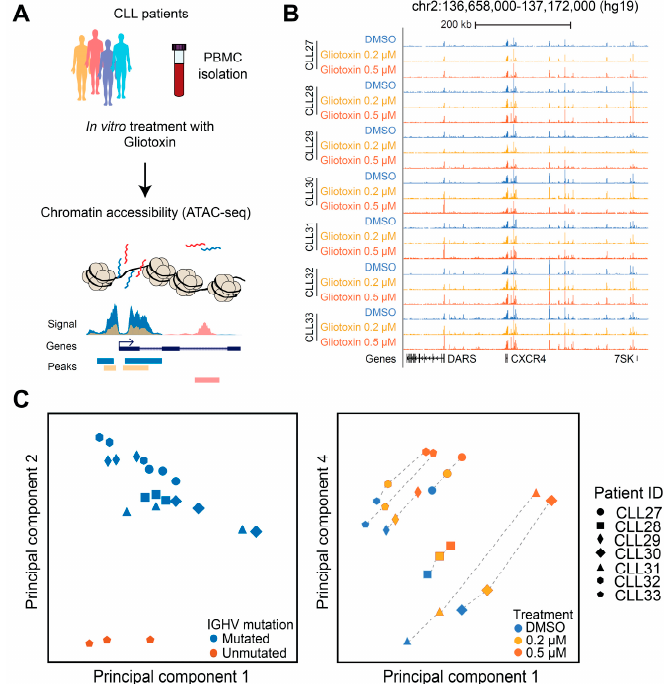
Figure 6. Chromatin accessibility changes in primary CLL cells upon in vitro treatment with gliotoxin. ( A ) ATAC-seq workflow to study the chromatin accessibility changes of CLL cells in response to gliotoxin treatment. ( B ) Representative genome browser visualization of the ATAC-seq signals in patient-derived CLL samples ( n = 7) treated with DMSO and two different concentrations of gliotoxin. A genomic region spanning ~50 kb around the CXCR4 locus is shown. ( C ) Unsupervised principal component analysis based on the chromatin accessibility for all 21 samples at all accessible sites in all samples. Samples are color coded according to their IGHV mutation status (left panel), or according to the in vitro treatment condition (right panel).